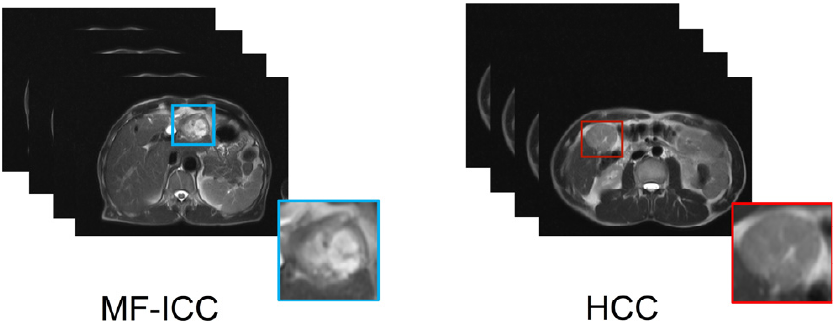
Figure 2. Collected mass-forming intrahepatic cholangiocarcinoma (MF-ICC)/hepatocellular carci- noma (HCC) T2 weighted imaging and corresponding lesion images (left MF-ICC, right HCC)